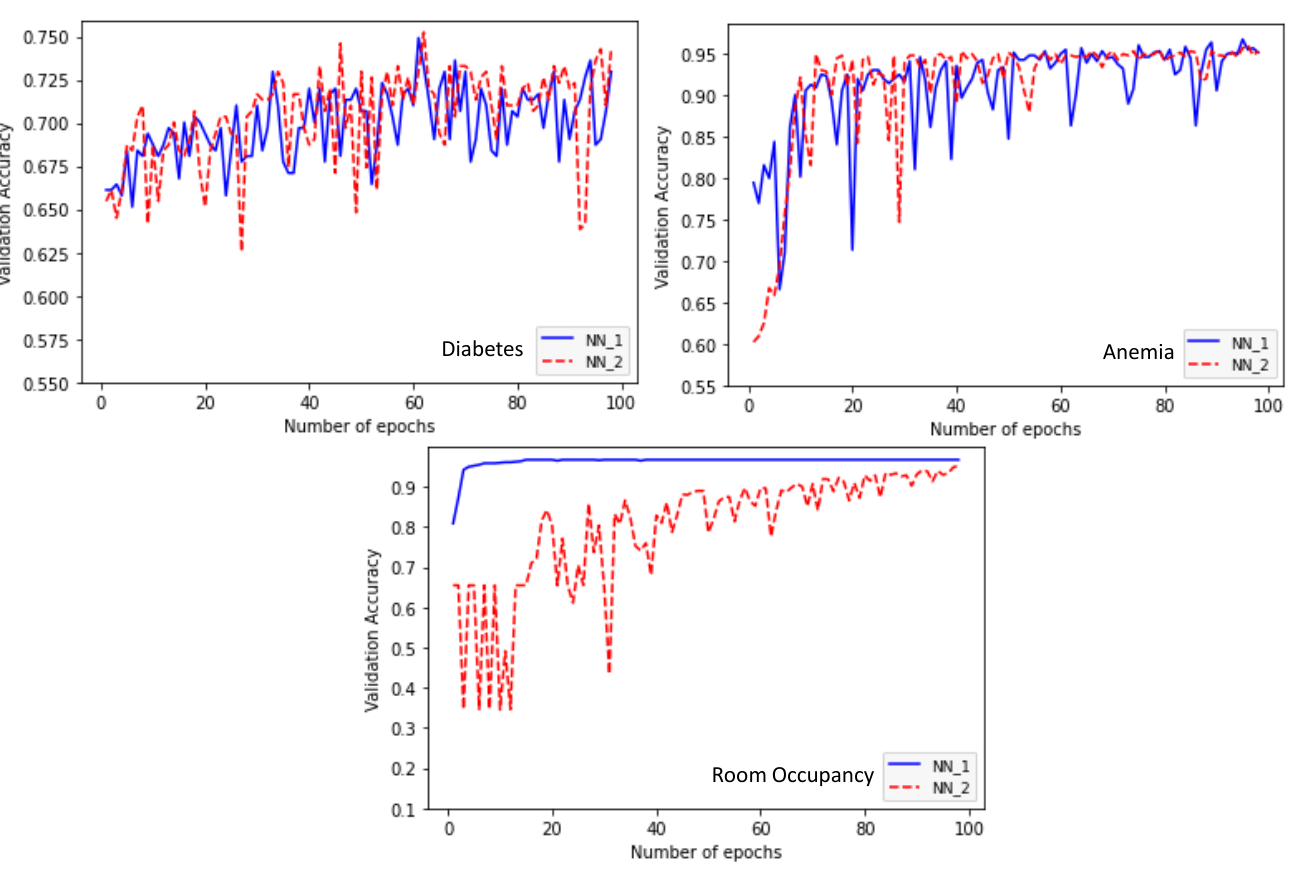
Figure 8. (Second Experiment) Classification (i.e., validation) accuracy evaluated on the testing data as a function of the number of training epochs obtained by the obtained by the best neural network (NN_1) using the Hyperspace A, and the best neural network (NN_2) using the Hyperspace B (Data sets: Diabetes, Anemia, and Room Occupancy). The corresponding hyperparameter values, accuracy, and total time (in minutes) needed for the hyper-tuning for each data set are given in Table 8.